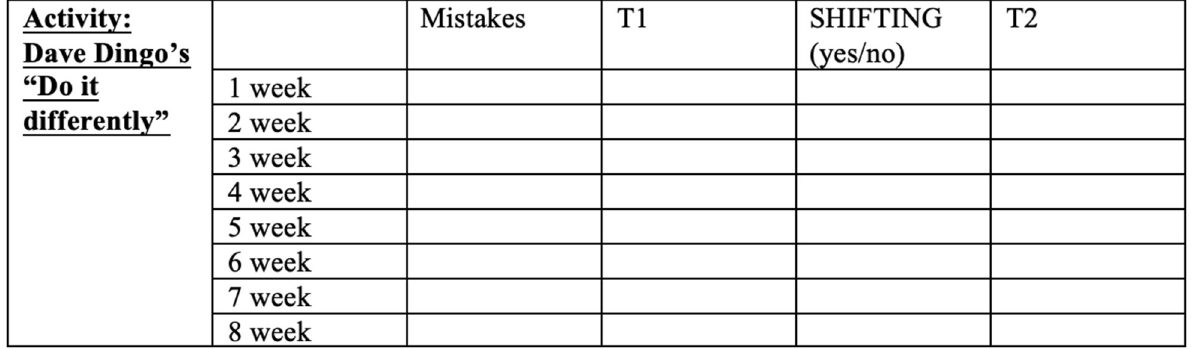
Figure 3. Example of the table format used to monitor the training.